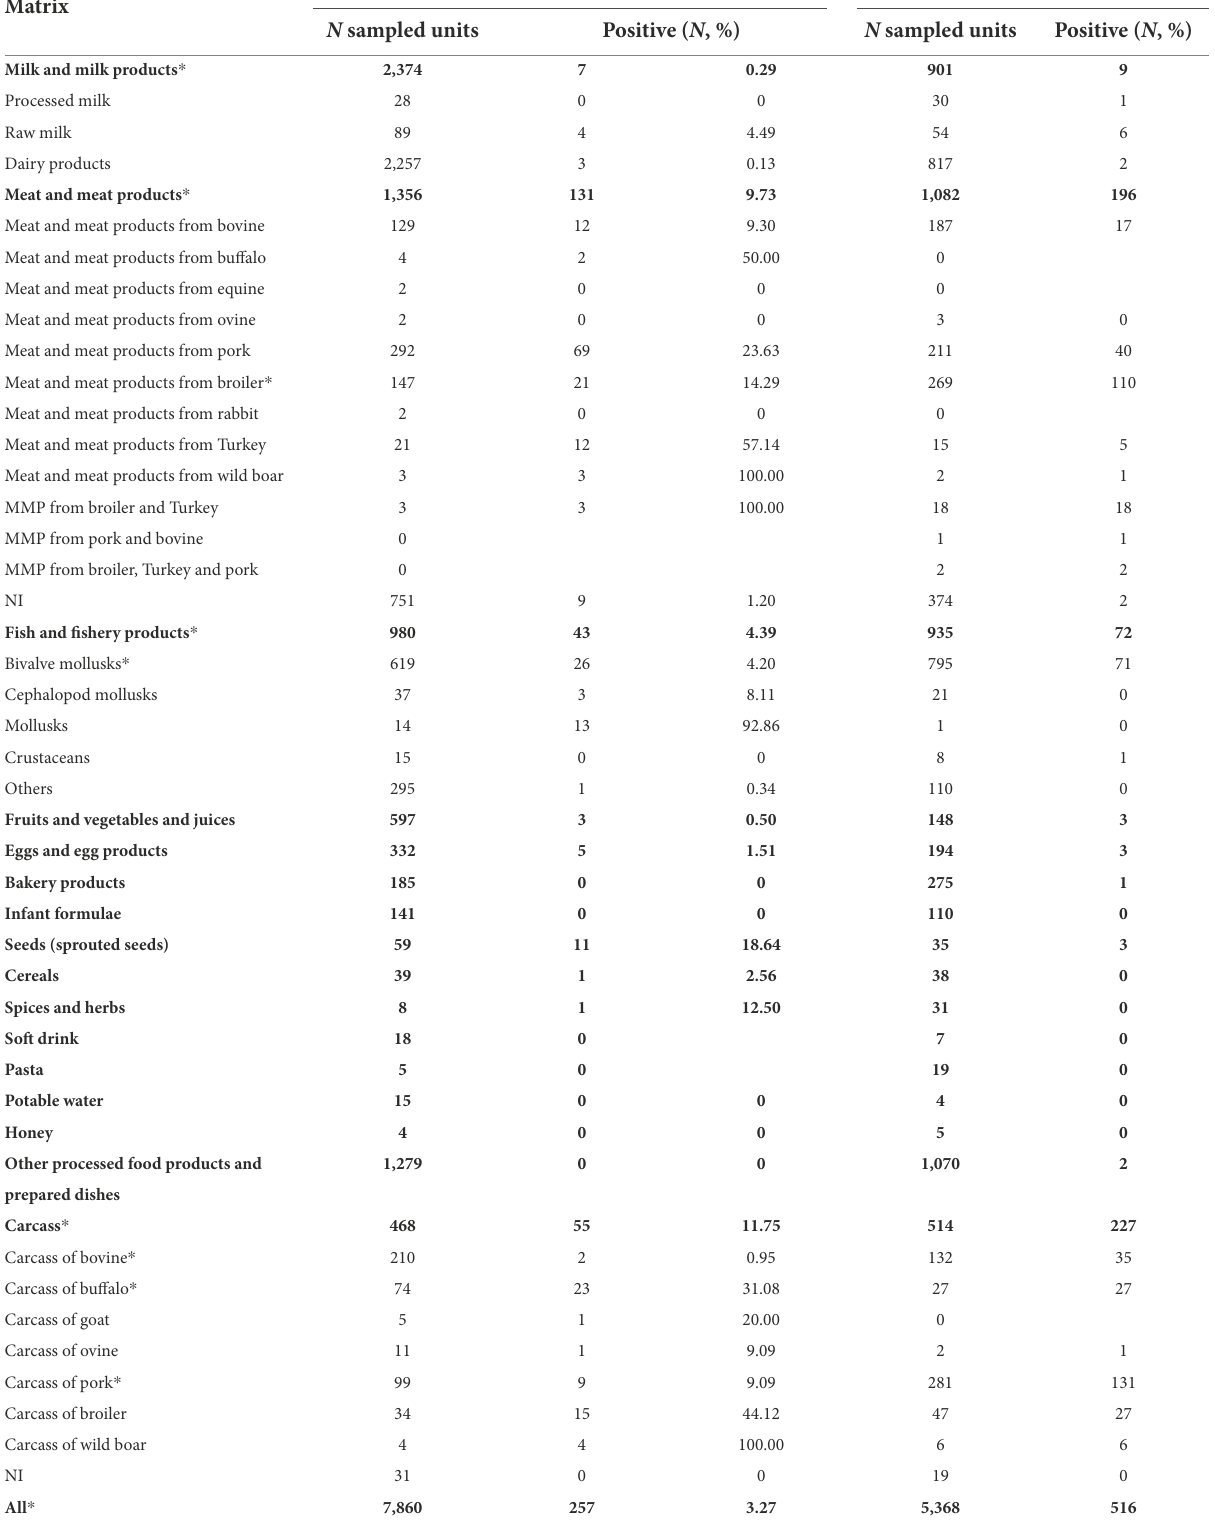
TABLE 1 Number (N) of samples collected in the context of official controls provided by Regulation (EC) No 2073/2005 and during self-monitoring from public or private enterprises and number (N) of Salmonella -positive samples grouped by source and years (2011–2015 vs. 2016–2021).